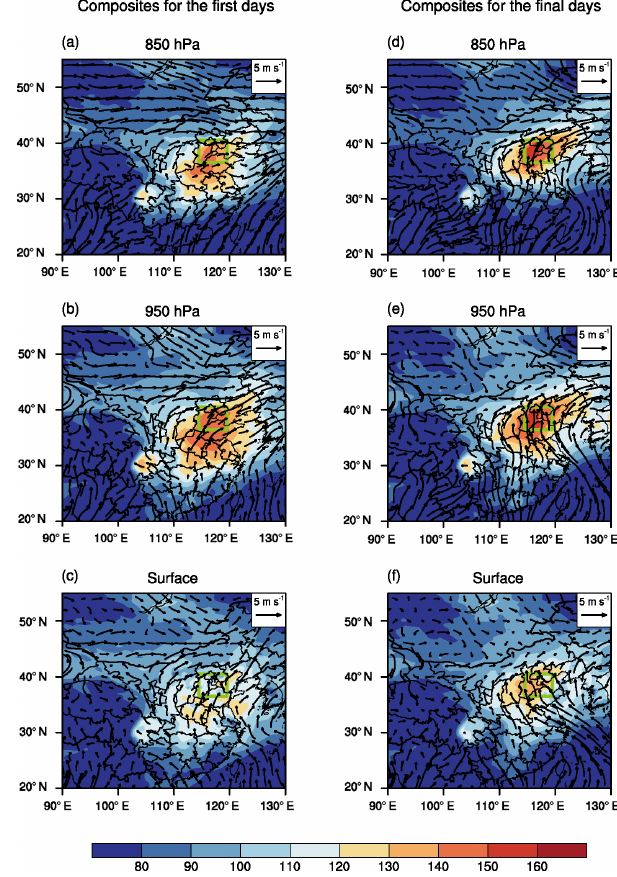
Figure 10. Winds (ms − 1 ) and the simulated O 3 concentrations (µgm − 3 ) averaged over the first day of the 15 OPEs that are cap- tured by the GEOS-Chem model with I_OPE > 0 at (a) 850hPa, (b) 950hPa and (c) the surface. Panels (d) – (f) are the same as (a) – (c) but are averaged over the final day of the OPEs. The solid green lines indicate North